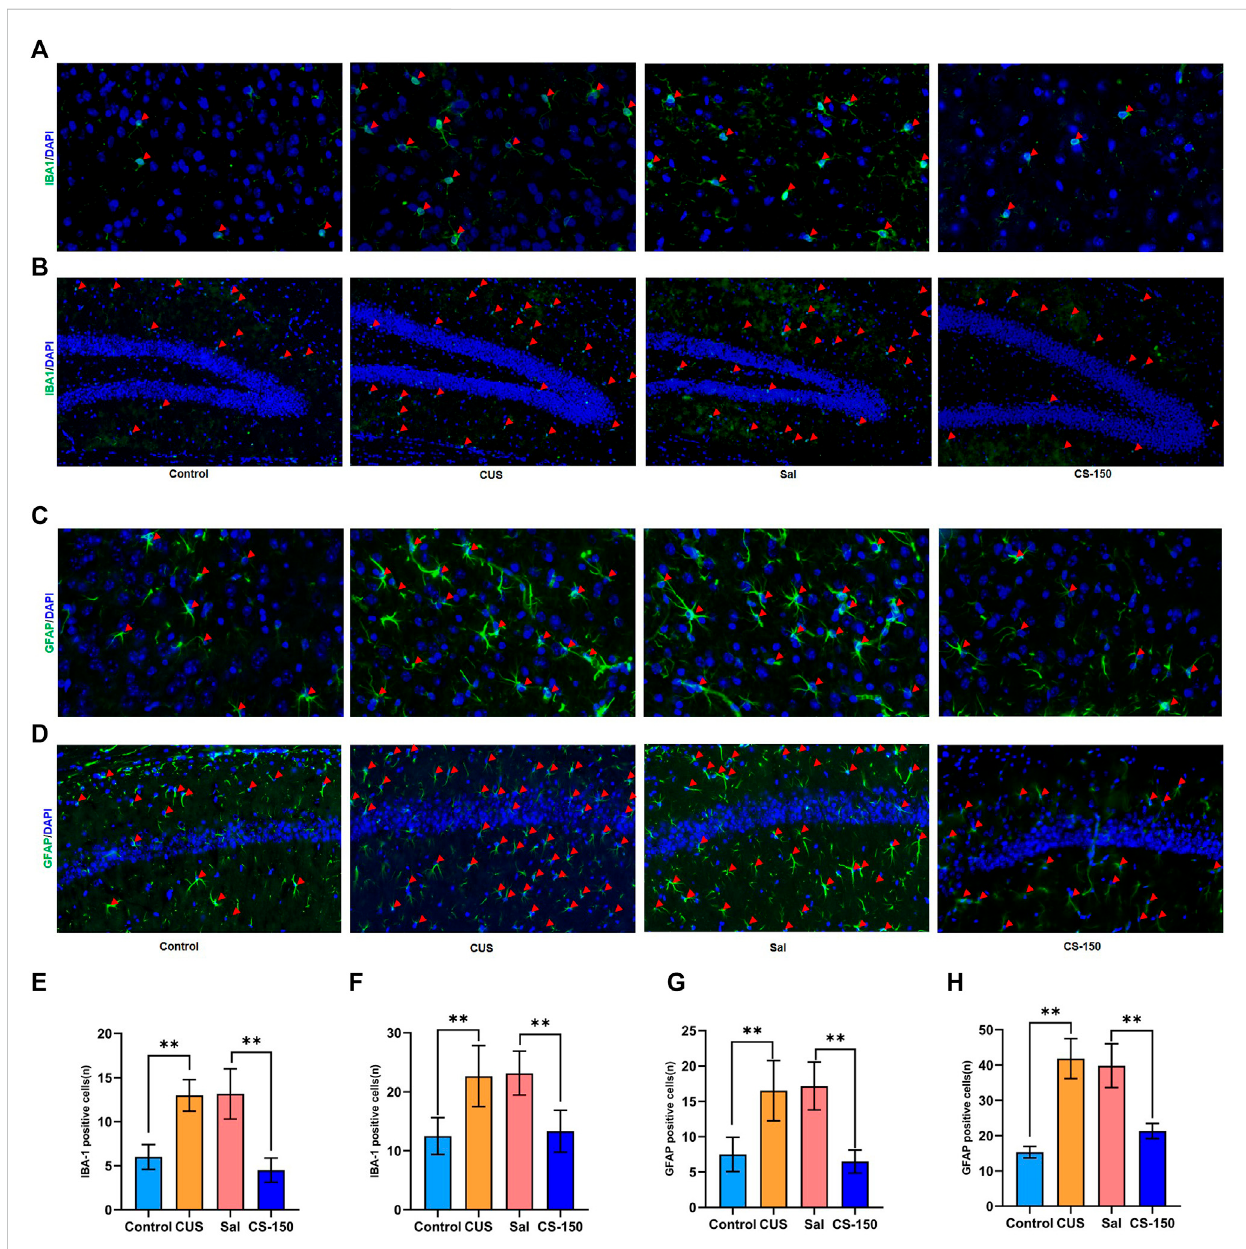
FIGURE 3 CS decreased CUS-induced microglial and astrocyte activation in both the PFC and HIP. (A, B) Images of IBA1-positive cells in the PFC (under ×400 magni fi cation) and DG (under ×200 magni fi cation) obtained by immuno fl uorescence. (C, D) Images of GFAP-positive cells in the PFC (under ×400 magni fi cation) and CA1 (under ×200 magni fi cation) obtained by immuno fl uorescence. (E, F) The number of IBA1-positive cells. (G, H) The number of IBA1-positive cells. Data are expressed as the mean ± standard error. * p < 0.05, ** p < 0.01, and p <